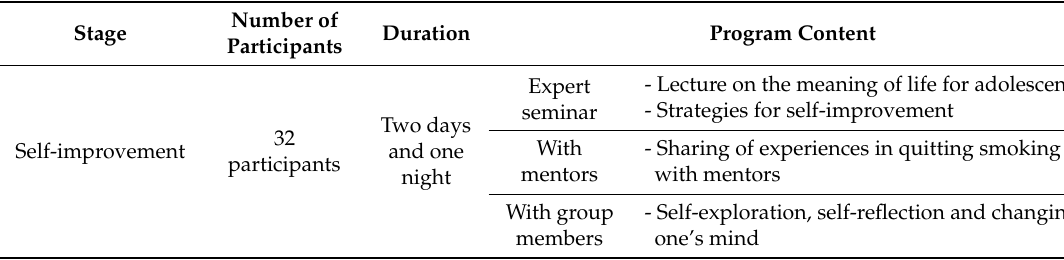
Table 3. Details of the Self-Improvement